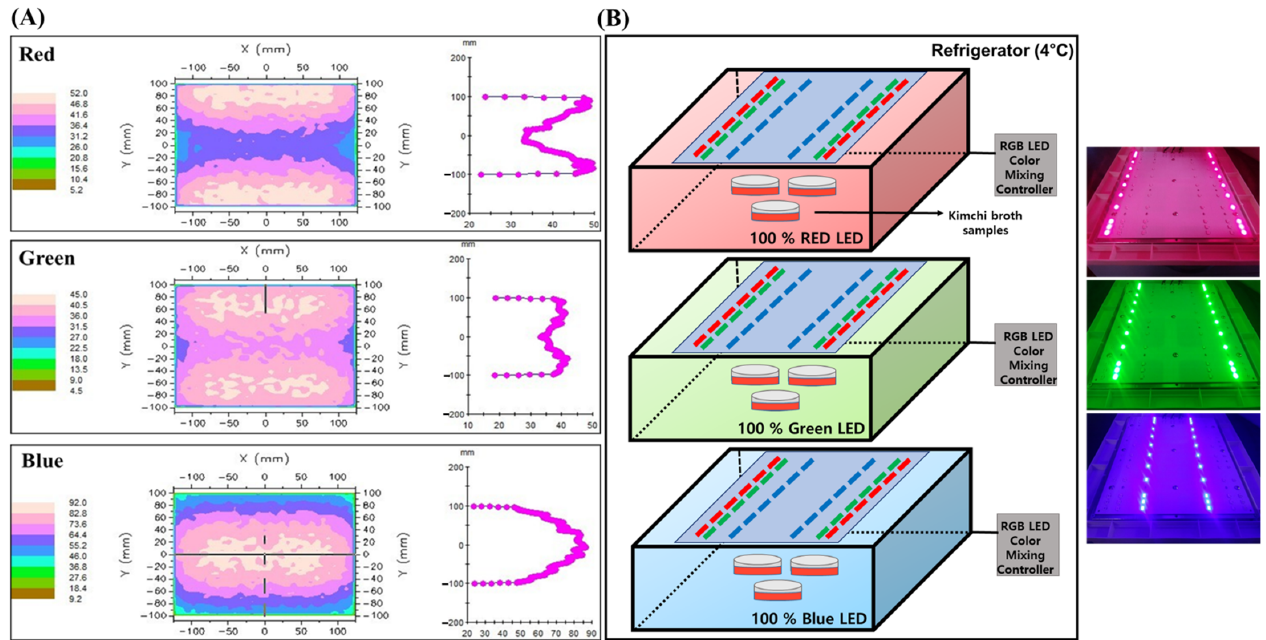
Figure 7. ( A ) Simulated irradiation patterns in LED light chamber at 10 mm distance. The inside dimensions of LED chambers were 25 × 20 × 10 cm (L × W × H). The distribution uniformity of the LED light systems is evaluated by optical analysis software packages, Light Tools (Synopsys Inc., Mountain View, CA, USA). ( B ) Schematic diagram of LED treatments. LED